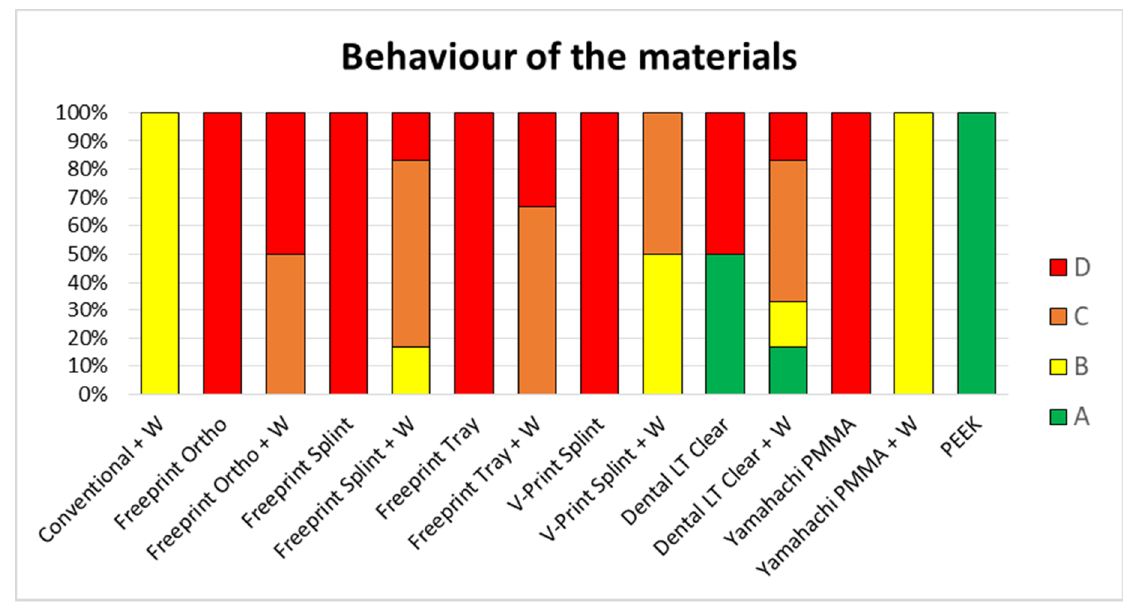
Figure 11. Classification of the behavior of the different samples with (+ W) and without wire to the testing (n = 6). Classification from the ideal (A) to the worst scenario (D). The conventional solution (Orthocryl + W) is compared to AM materials and SM materials. Different AM materials can be found: Dental LT clear (SLA), Freeprint tray (DLP), Freeprint ortho (DLP), Freeprint splint (DLP) and V-Print splint (DLP). Furthermore, different SM can be found; Yamahachi PMMA and Smile PEEK.